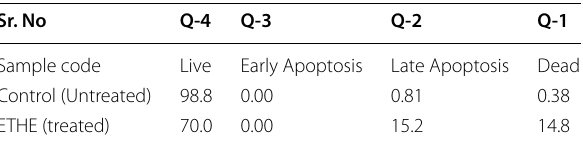
Table 3 The effect of ETHE of Convolvulus pluricaulis of on HepG2 cells apoptosis Sr.